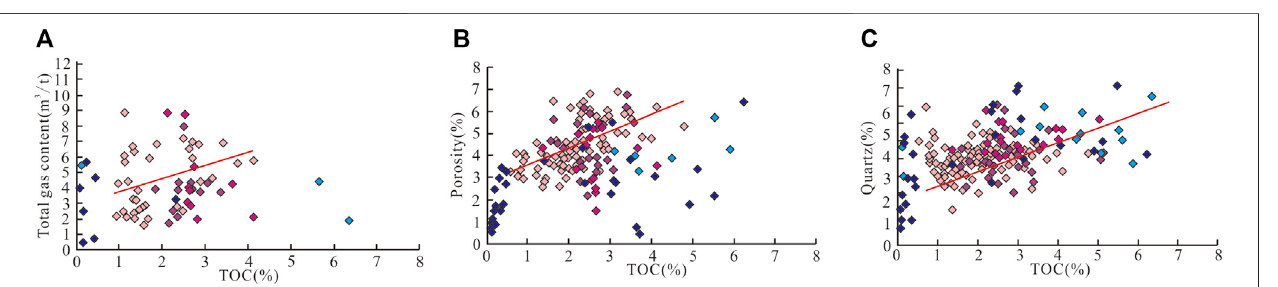
Frontiers in Earth Science |